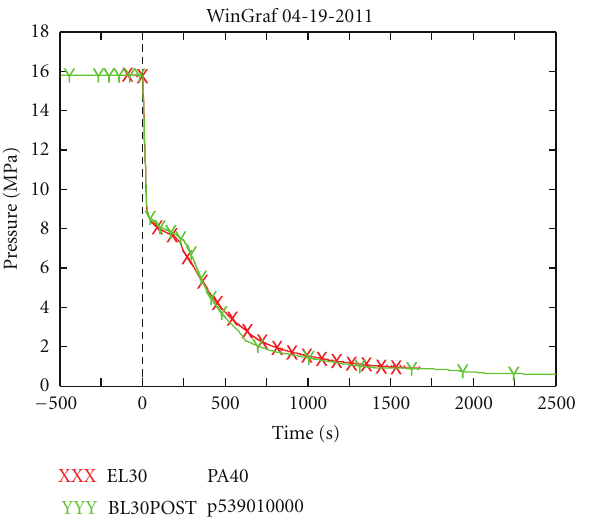
Figure 5: Secondary system pressure.